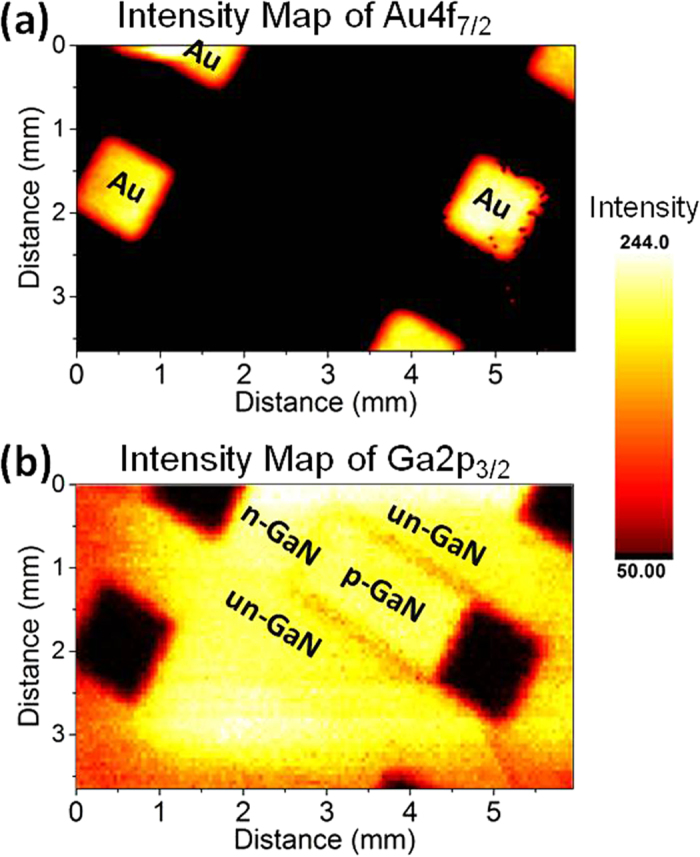
XPS Intensity Maps.Areal maps of the intensity of the Au4f7/2 and Ga2p3/2 peaks derived from peak areas.